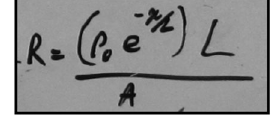
FIG. 9. Equation set up by Zad.